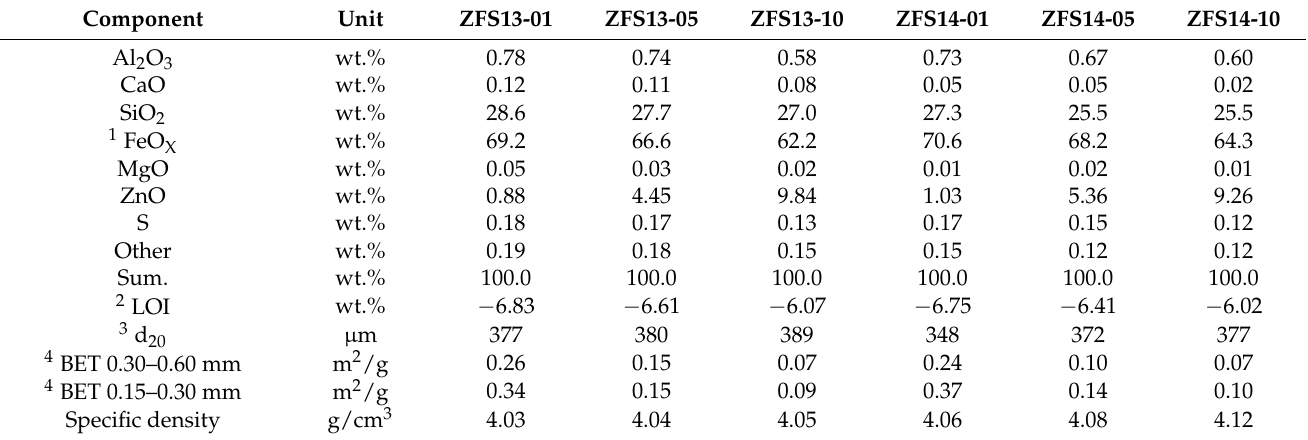
Table 2. Normalized chemical compositions determined by ICP–MS and material data of ZFS